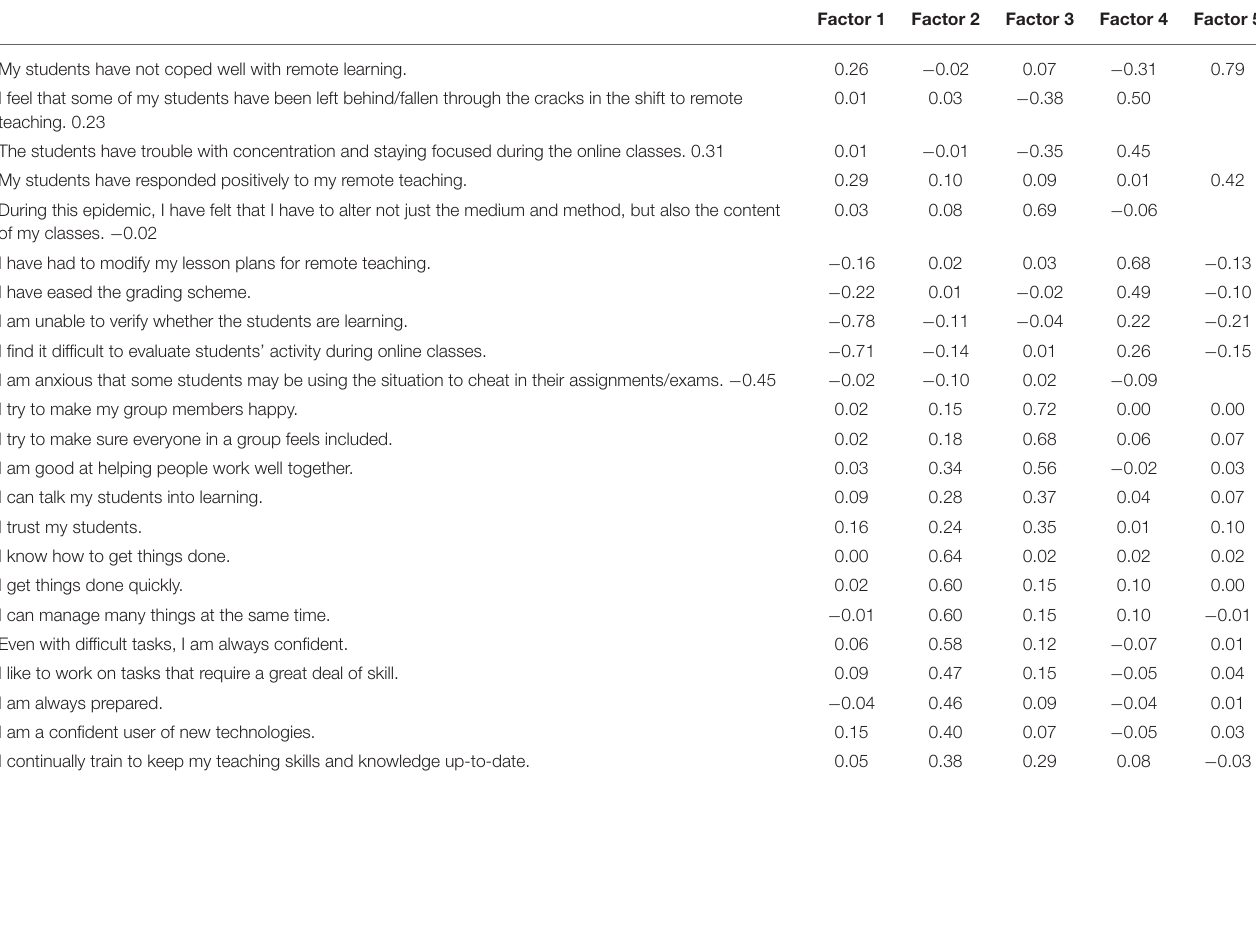
TABLE A6 | Results of exploratory factor